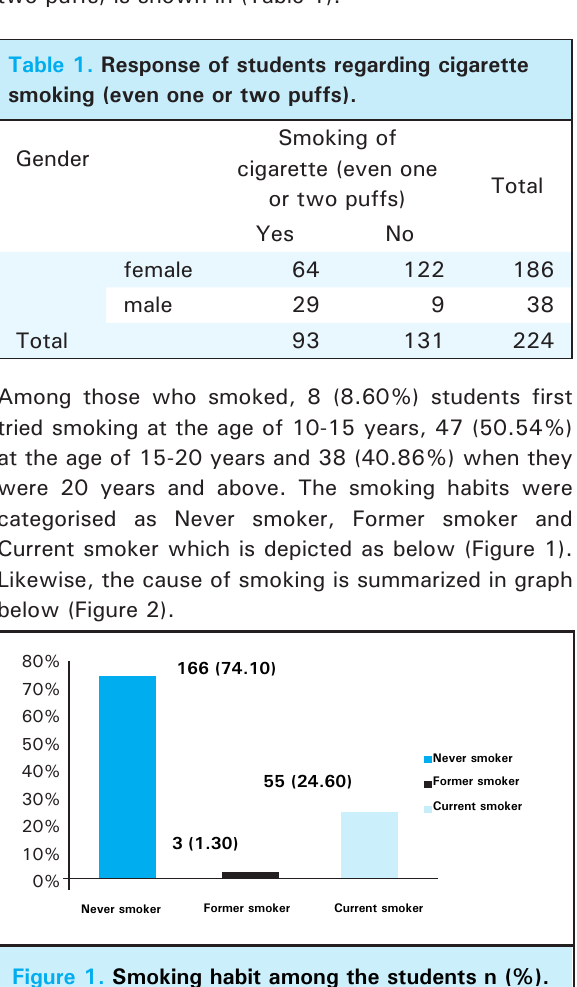
Figure 1. Smoking habit among the students n